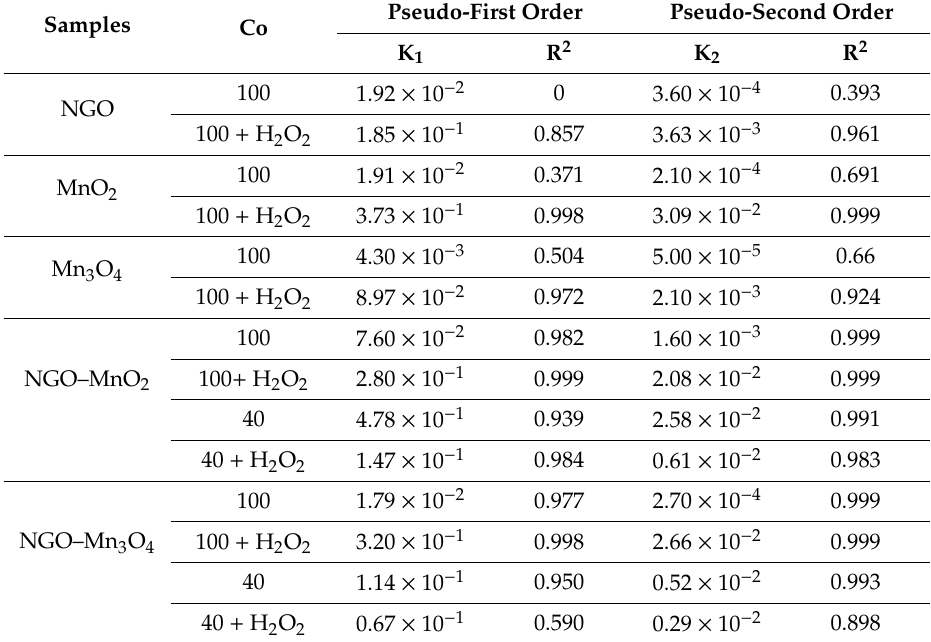
Table 2. Kinetic